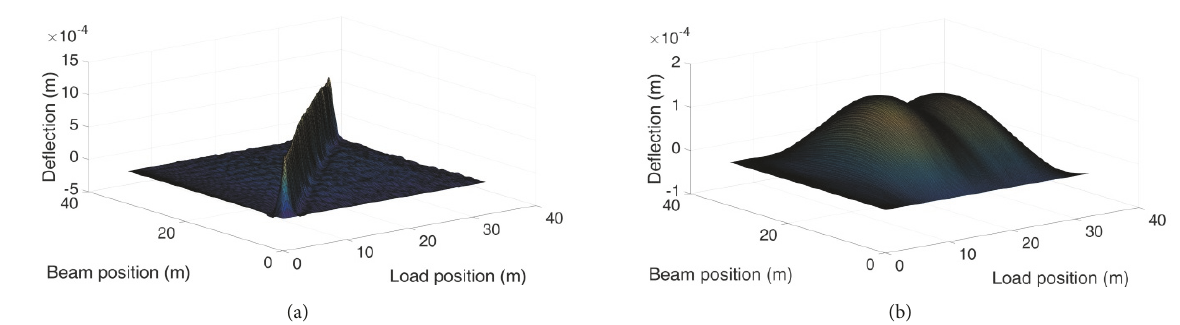
Figure 2: Deflections of double simply supported rail-bridge system with different positions of the moving load: (a) first beam; (b) second